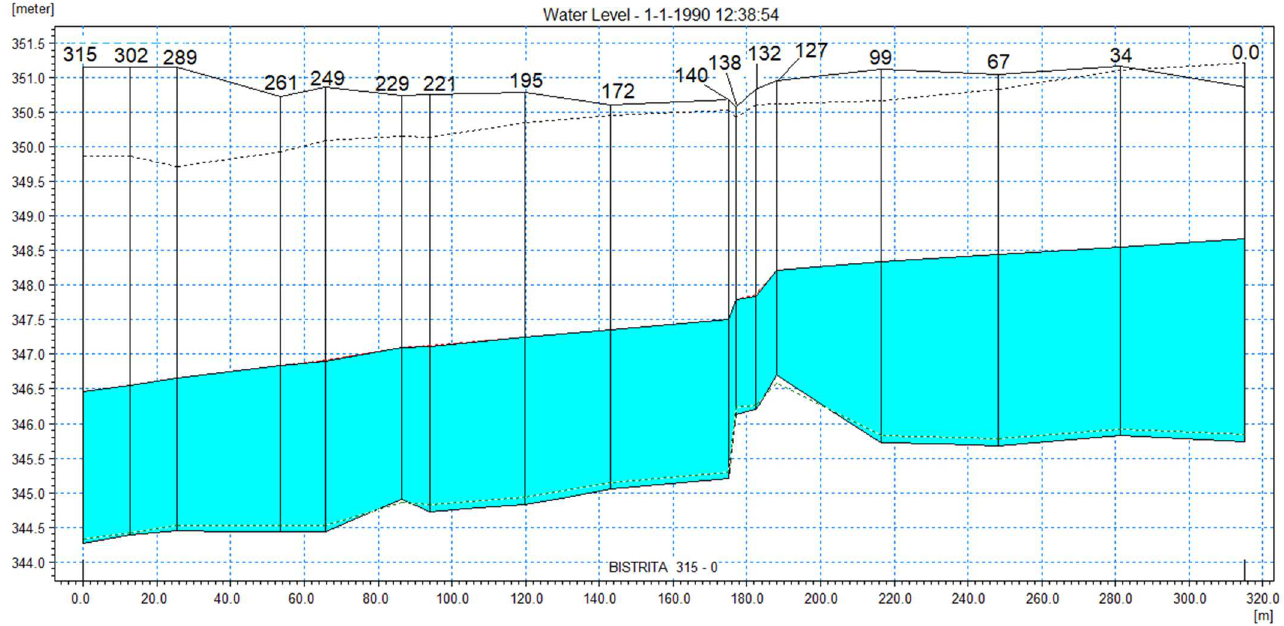
Figure 10. Water level for flow Q = 128 m 3 /s, representing an extreme flood flow recorded in 2020. For the case where there is only one weir, the existing one.